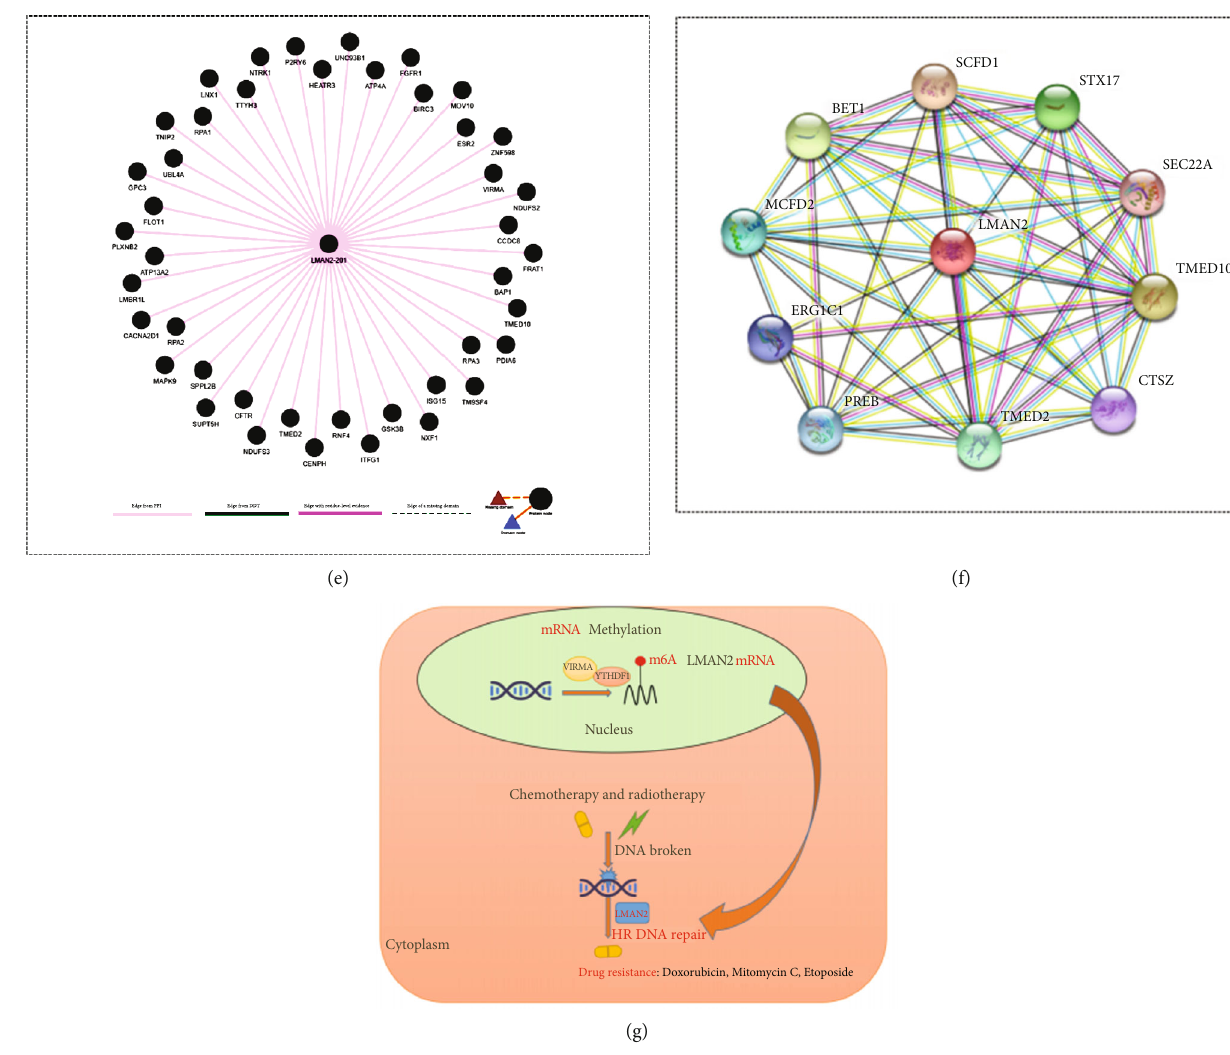
Figure 8: LMAN2 expression is related to DNA damage repair. (a) Gene Ontology GO annotation analyses revealed the functional enrichment of LMAN2. (b) Plots of enrichment derived from GSEA Enrichment Analysis (GSEA). The fi ndings of GSEA showed that ALLOGRAFT_REJECTIOO, IL-2_STAT5_SIGNAL and MYC_TARGETS_V1 were di ff erentially enriched in LMAN2-related enrichment score (ES), normalized p value (NOM p val), and normalized ES (NES). (c) ETV2, GTF2F1, and SPDEF transcriptional regulation of LMAN2 (GRNdb). (d) Predicted protein-protein interaction network (GeneMANIA). (e) Predicted protein-protein interaction network (DIGGER). (f) Predicted protein-protein interaction network (STRING). (g) m6A methylation modi fi cations of RNA may a ff ect LMAN2 expression, which is associated with homologous recombination (HR) in the DNA damage repair pathway of LMAN2. Predict the mechanistic pattern of LMAN2 in breast